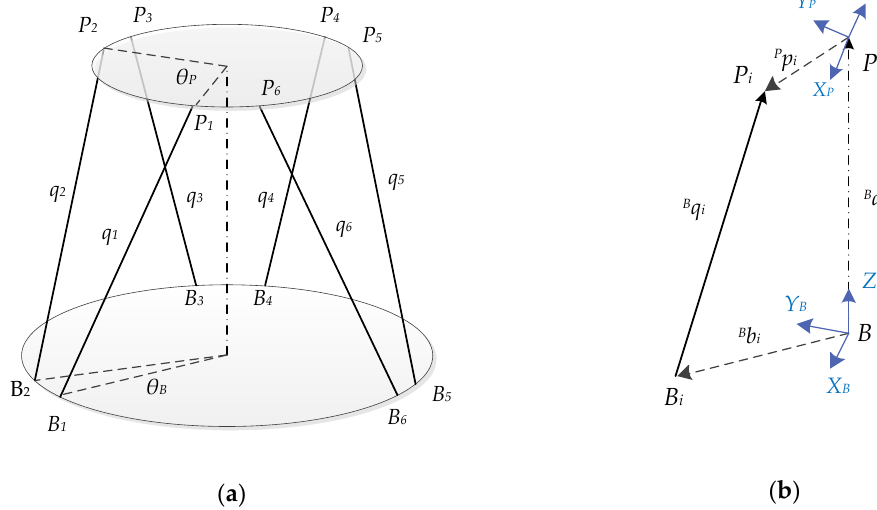
Figure 3. Stewart platform schemes: ( a ) Stewart platform frame assignment; ( b ) vector diagram for the ith actuator.